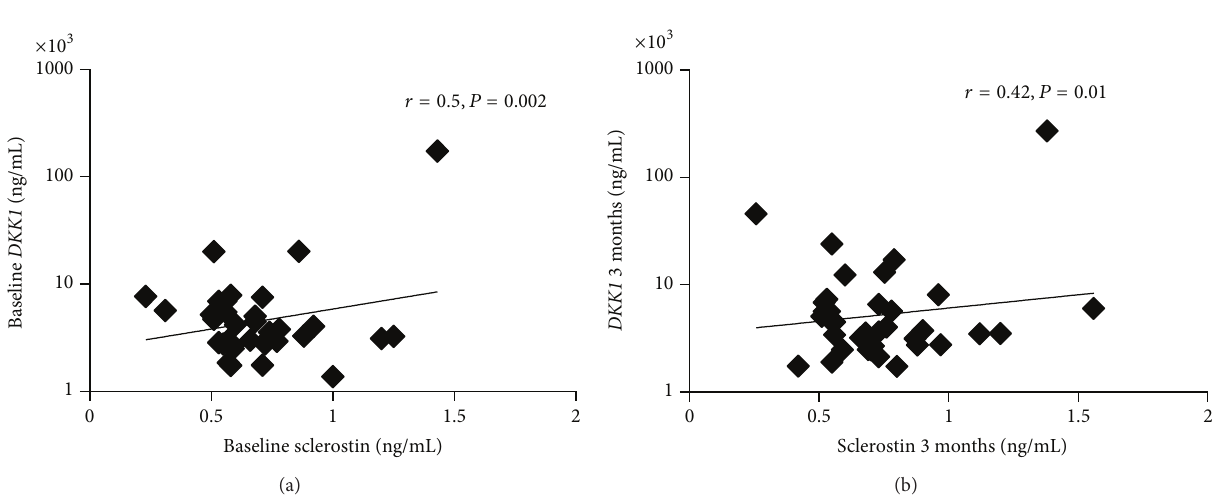
Figure 1: The correlation between circulating sclerostin and DKK1 at baseline (a) and at 3 months (b) following a loading dose of vitamin D 2 (300,000